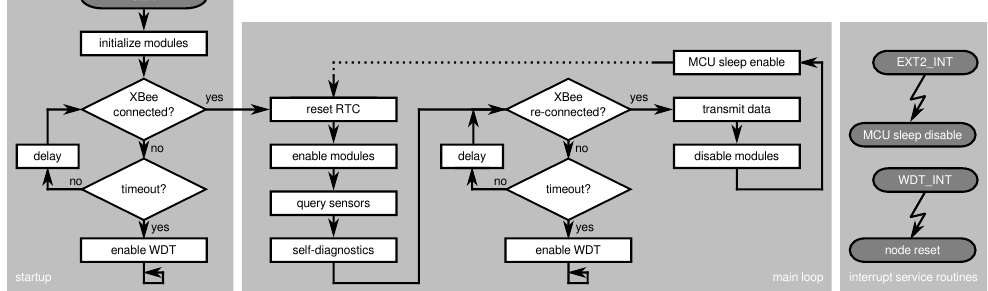
Figure 11. Simplified sensor node demo software